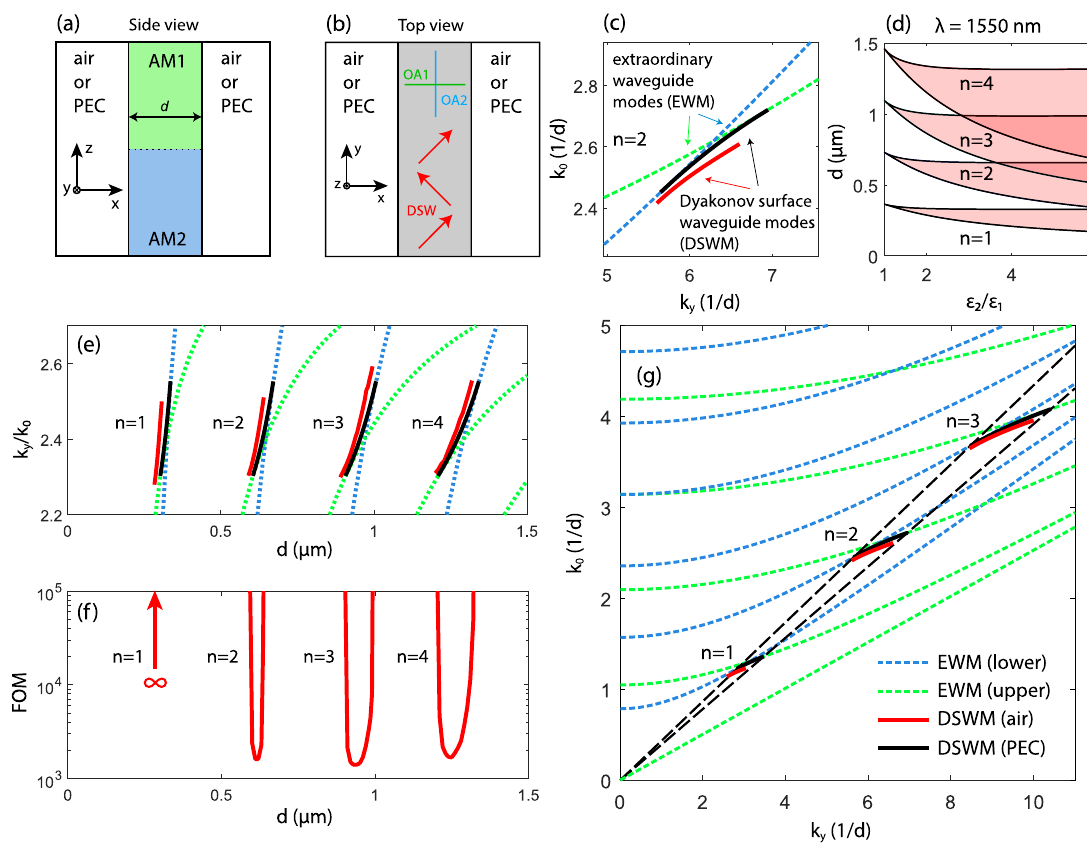
Figure 3: (Color online) Side view (a) and top view (b) of the interface between two anisotropic materials bounded by air or PEC half-spaces from left and right. Optical axes of anisotropic materials are parallel to coordinate axes as shown by the green and blue lines in panel (b). DSWM in such con fi guration is a superposition of DSWs re fl ecting from both sides of the boundary at an angle α close to 45 ° as is shown in panel (b) by red arrows. (c), (e) and (g): Extraordinary waveguide modes (EWM) of the upper and lower anisotropic slabs (dashed green and blue lines) with PEC boundaries and DSWMs in the case of a PEC (solid black line) or air (solid red line) boundary. (d): Range of the waveguide width, d , in which DSWMs exist. (f): Figure of merit (FOM) calculated for the case of air boundary. All calculations are made for ε 1 (cid:1) 9, ε 2 (cid:1) 16 except for panel (d). PEC, perfect electric conductor; DSW, Dyakonov surface wave; DSWM, Dyakonov surface waveguide